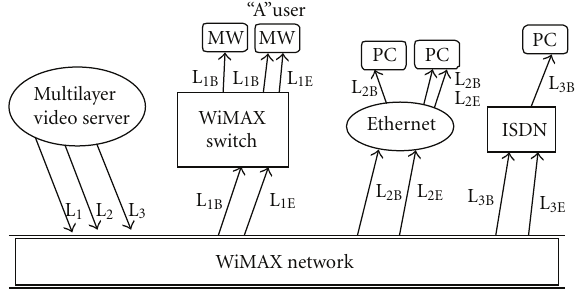
Figure 2: Scalable multiresolution video services with multilayer